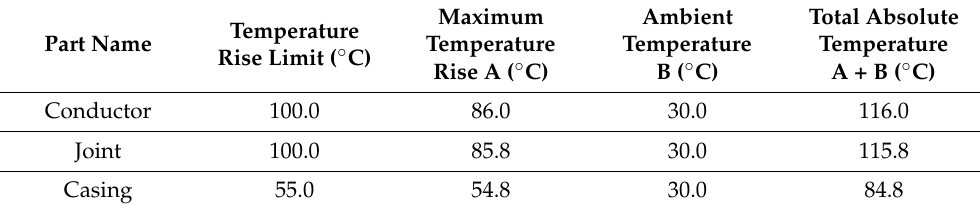
Table 3. The temperature rise specifications of IEC 61439-6 used in the